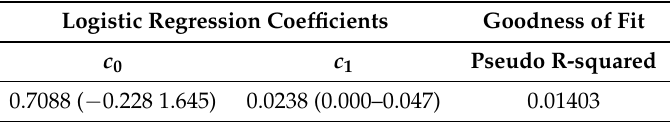
Table 8. Model coefficients (with confidence interval in parenthesis) and goodness of fit metrics for rain vs. power logistic